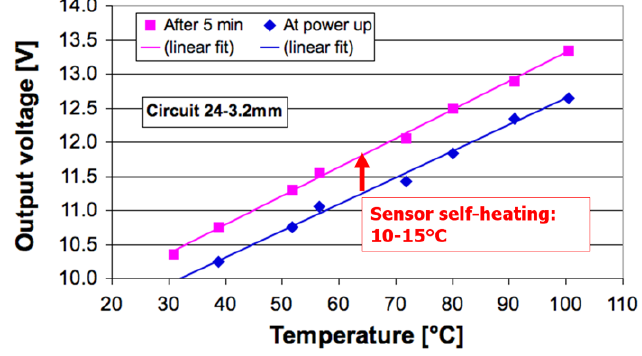
Figure 16. Temperature output voltage vs. global sensor temperature, measured at t = 0 min since power up (lower line), and at t = 5 min (upper